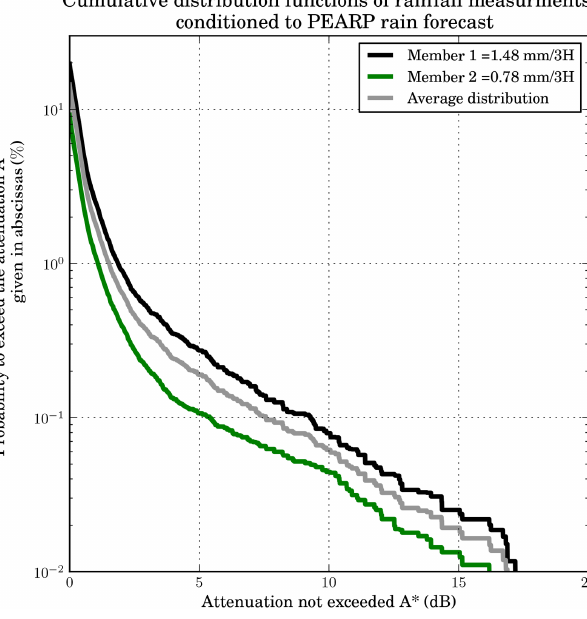
Figure 4. Probability of exceeding the attenuation threshold given in abscissas. Two distributions are selected according to the value of two ensemble members (black and green lines). The gray line stands for the average of those two